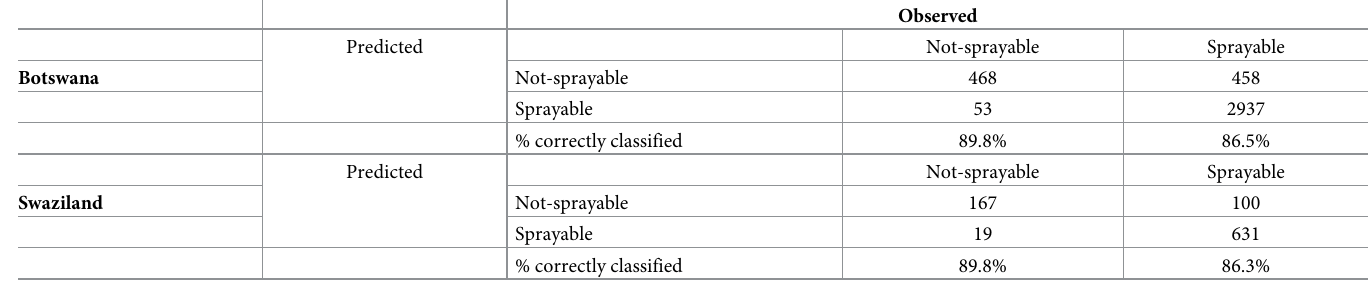
Table 4. Performance of the super learner models when applied to the test data. Classifications were made using the country specific cutoffs at which CV-classification accuracy was equal for sprayable and not-sprayable structures.